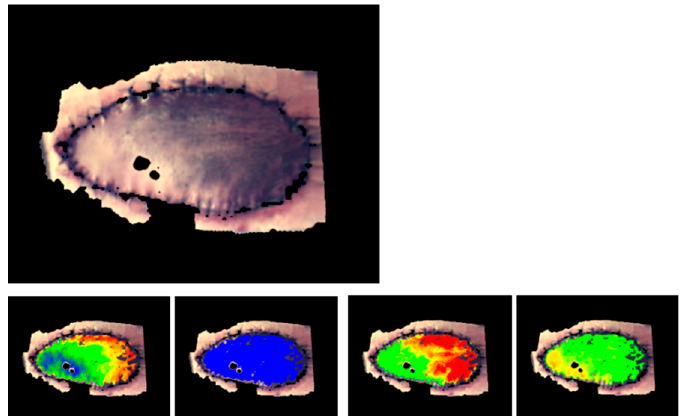
Figure 4. Transplant at day 1; survey images vHb_1, xHbO 2 _1, vHb_2, xHbO 2 _2; the arterial influx is on the right side of the flap; color scales for vHb and xHbO 2 , as depicted in Figure 1.